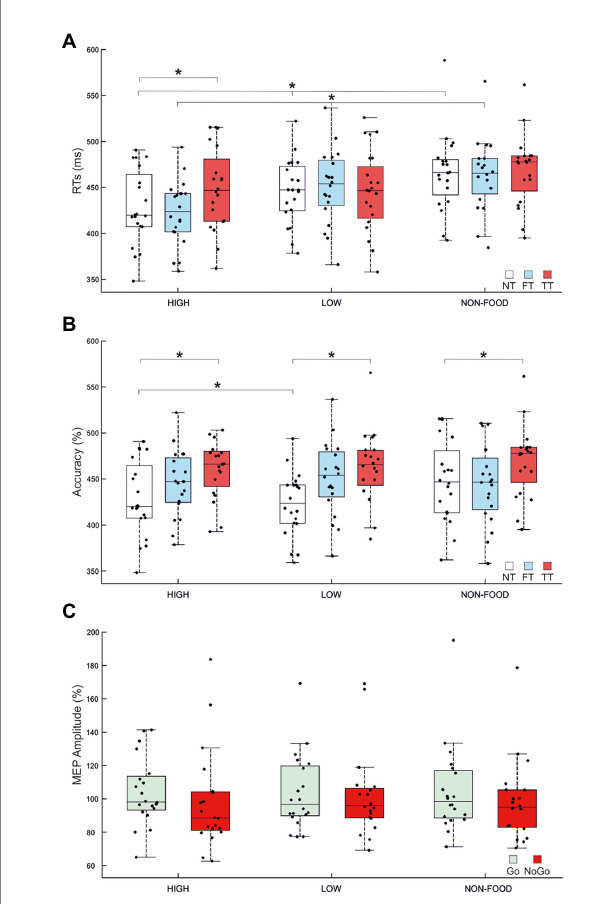
FIGURE 3 Effects of image type and TMS over MI. (A) Mean go reaction times (RTs) for High/Low-Calorie and Non-food trials for NT (No TMS), FT (Fixation TMS) and TT (Target TMS). In NT and FT, high-calorie RTs were faster than RTs collected for low-calorie and non-food images. Low- calorie RTs were also faster compared to non-food RTs. A specific increase of high-calorie RTs emerged between NT and TT conditions. (B) Mean accuracy for High/Low-Calorie and Non-food trials for NT, FT and TT. Participants were more accurate for high-calorie compared to low calorie NT trials. Accuracy decreased in TT conditions, regardless of stimulus type. (C) Mean normalised amplitude of motor evoked potentials (MEPs). MEP amplitude collected during the target presentation (TT) for High/Low-Calorie and Non-food trials in Go and NoGo conditions is expressed as percentage of the MEP amplitude collected at baseline (FT). As expected, corticospinal excitability is lower in NoGo conditions ( p = 0.036). In each panel, black dots represent individual data. The box and wiskers show the Median ± 1.5 interquartile range (IQR) and asterisks represent